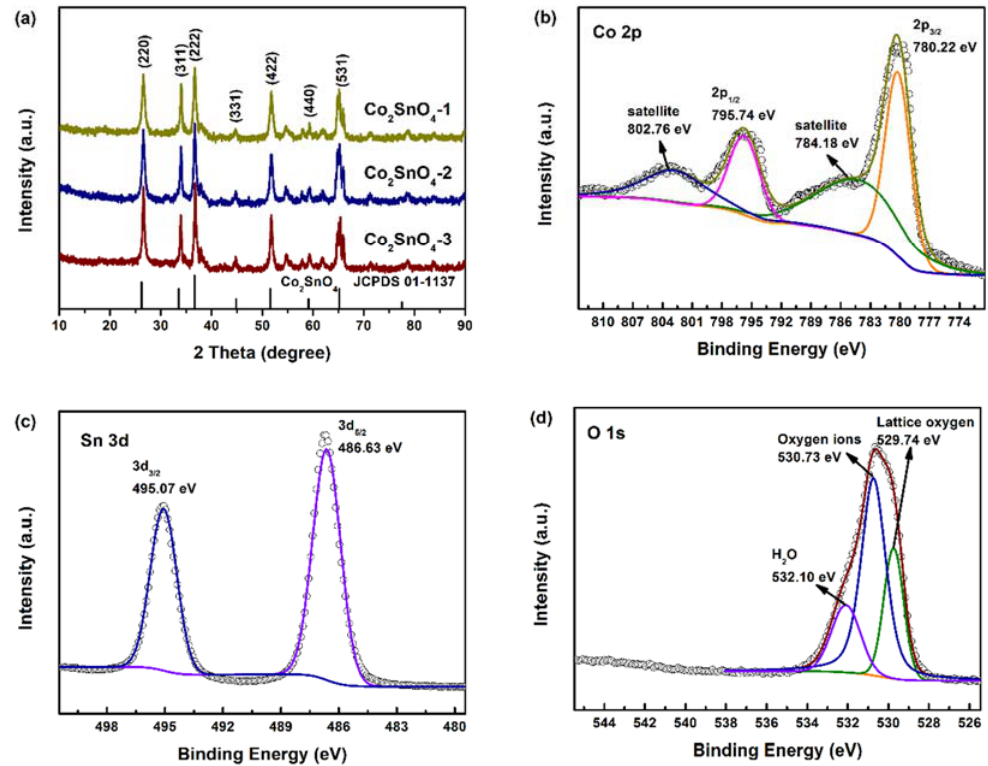
Figure 2. ( a ) XRD patterns of Co 2 SnO 4 -1, Co 2 SnO 4 -2, and Co 2 SnO 4 -3. ( b – d ) High-resolution XPS spectra of Co 2p, Sn 3d, and O 1s for Co 2 SnO 4 -2. The TG-DSC curves of Co 2 Sn(OH) 6 -1, Co 2 Sn(OH) 6 -2, and Co 2 Sn(OH) 6 -3 xerogels